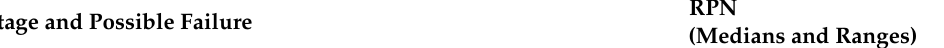
Table 2. Possible failures at each stage of the process and corresponding RPNs, ranked by RPN in each